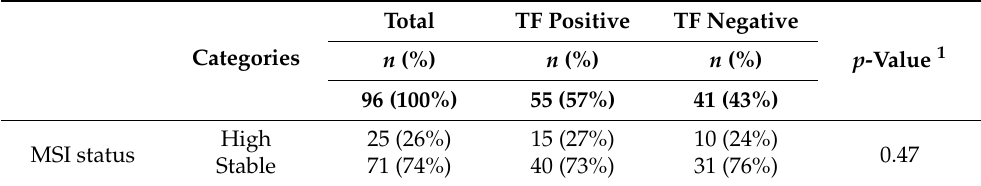
Table 2. Expression of TF antigen according to microsatellite instability (MSI) status.